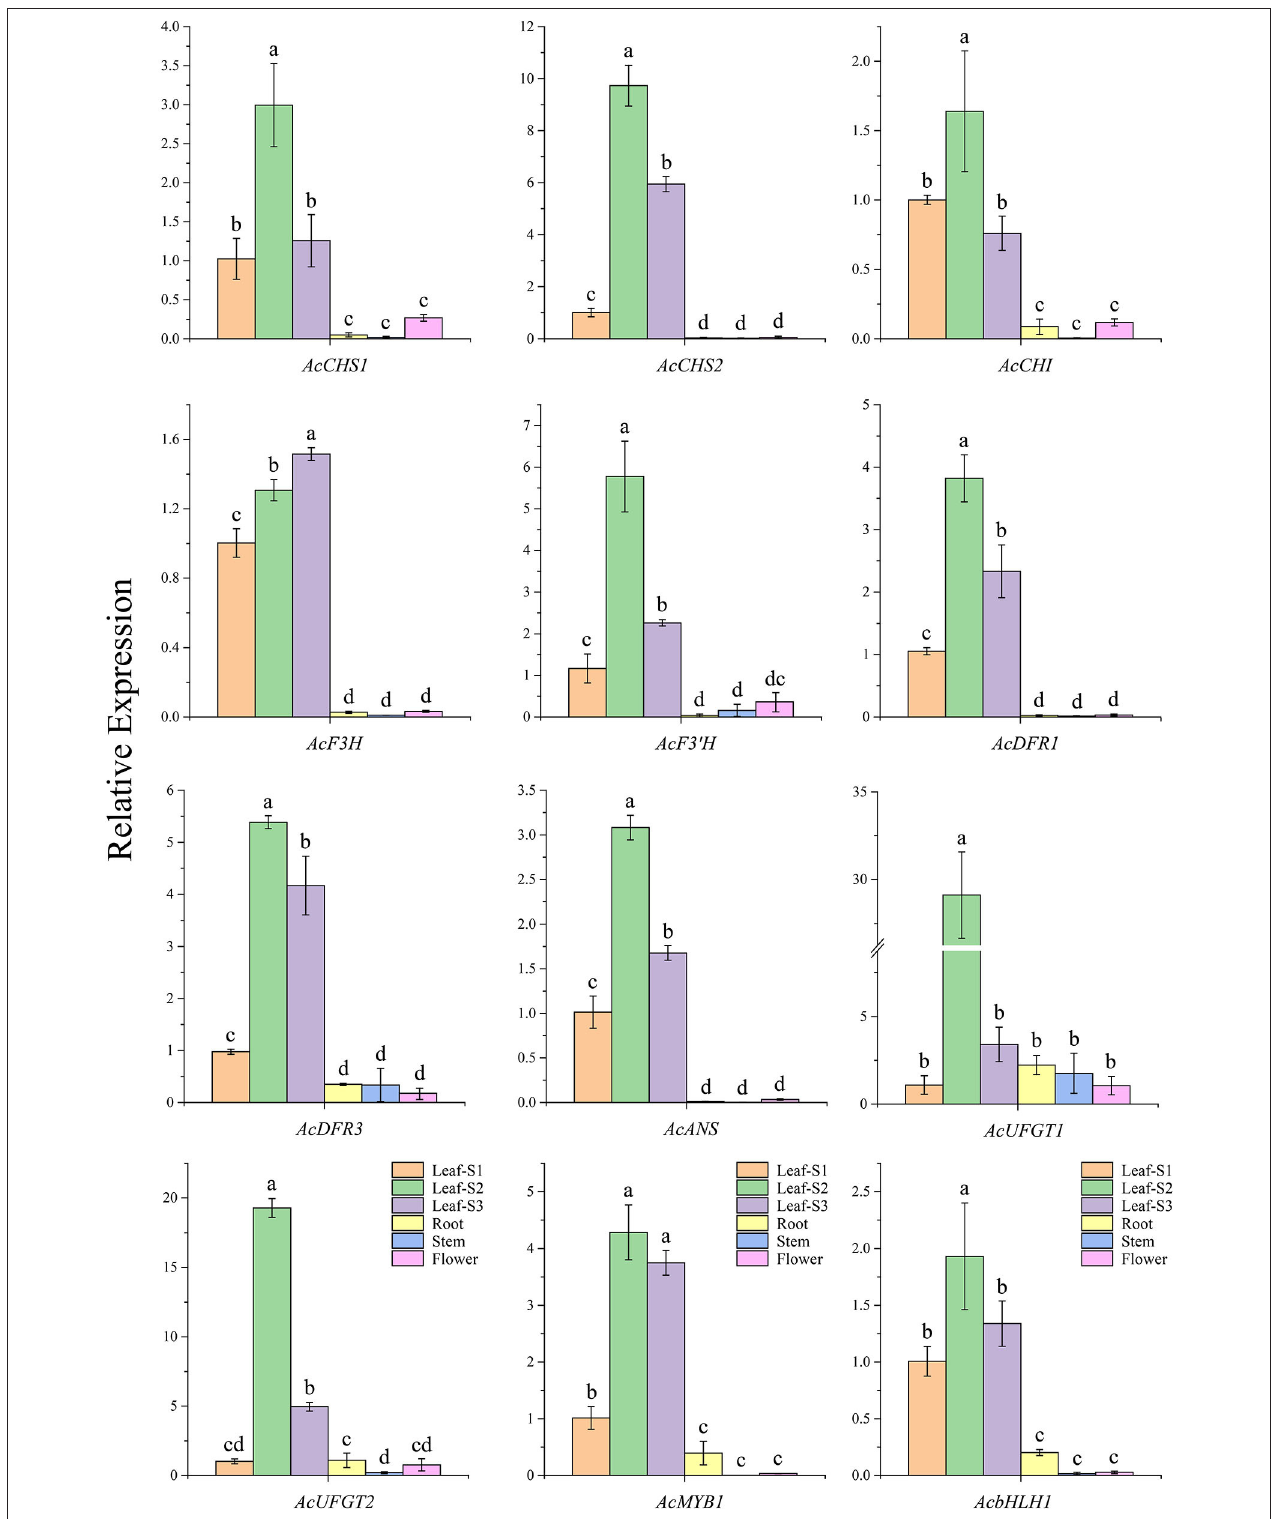
FIGURE 3 | The relative expression levels of 10 anthocyanin structural genes, AcMYB1 , and A cbHLH1 in various tissues of A. commutatum “Red Valentine” by qRT-PCR. The relative expression was calculated based on the 2 − 11 CT method using AcEF-1 α gene as the reference gene.